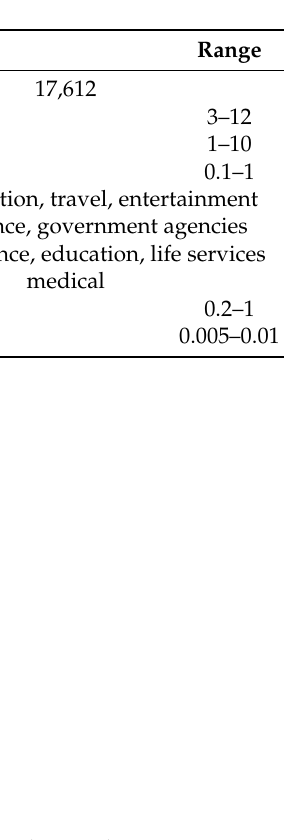
Figure 1. Output probabilities of randomized algorithms on adjacent datasets.